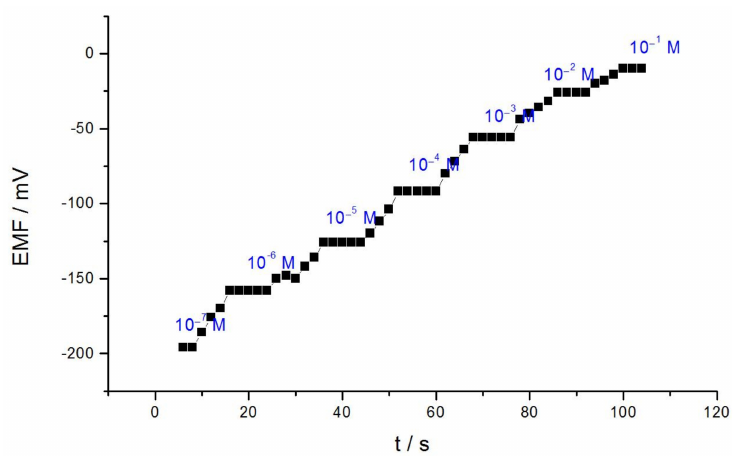
Figure 2. The time of response of [10 − 3 M] concentration of proposed aluminum